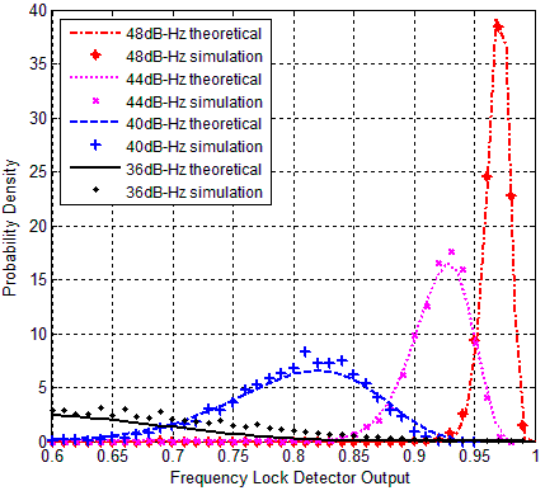
Figure 1. PDF of theoretical and simulation under high C / N 0 ( T = 1 ms, M = 20).